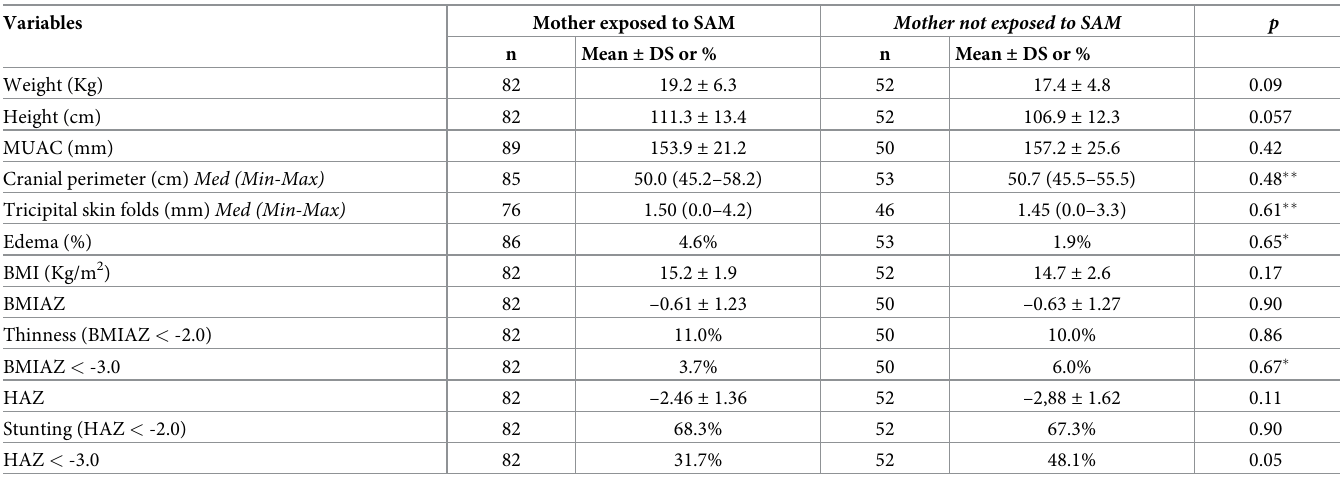
Table 2. Anthropometry and nutritional status of